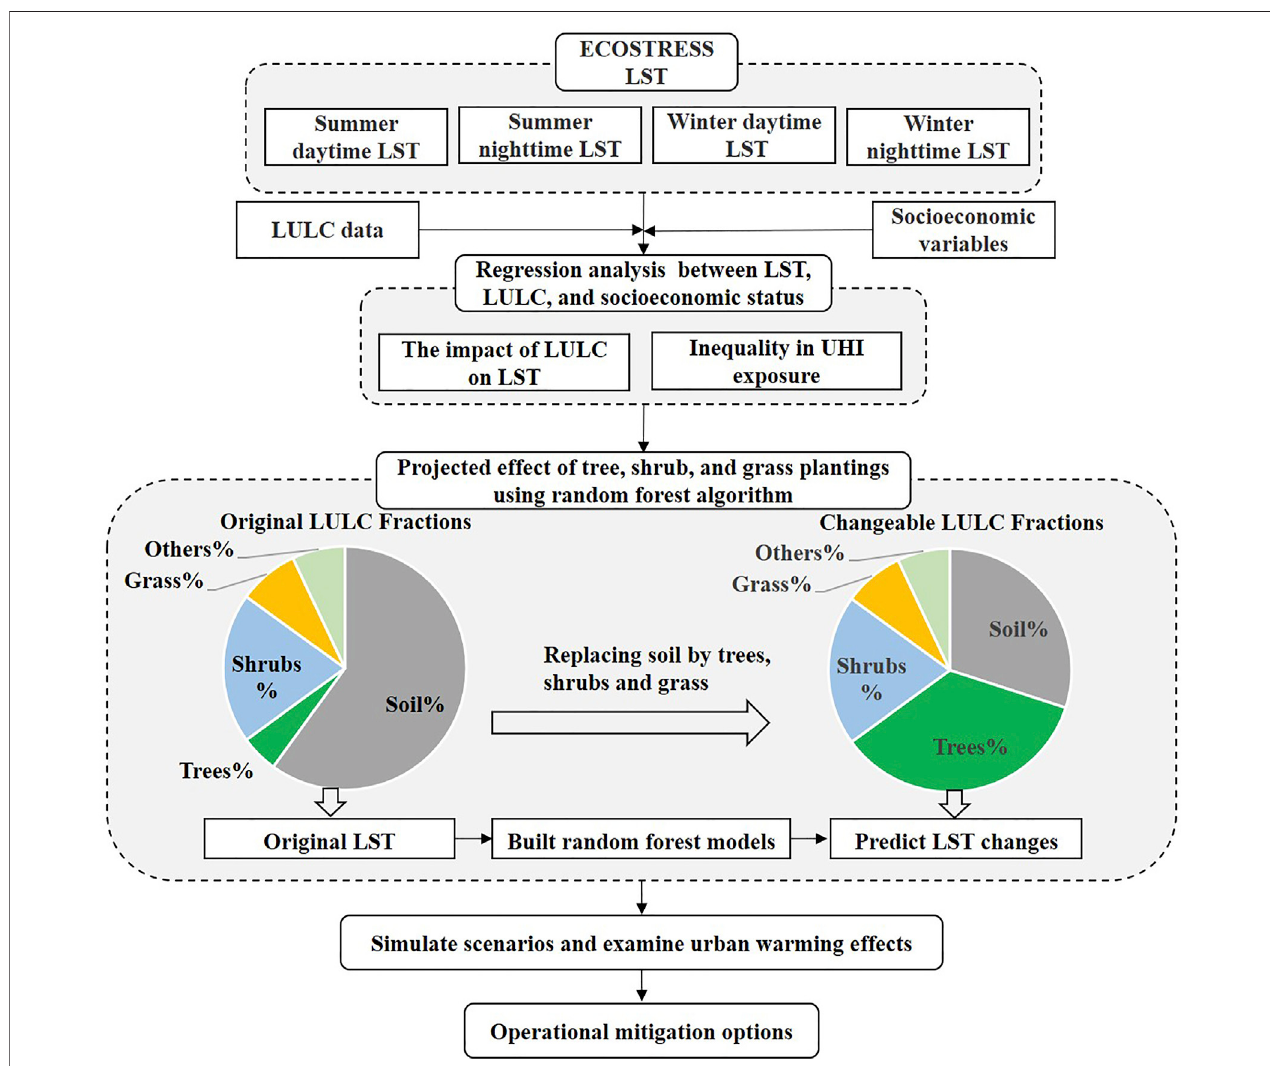
FIGURE 2 | Data processing and analytical